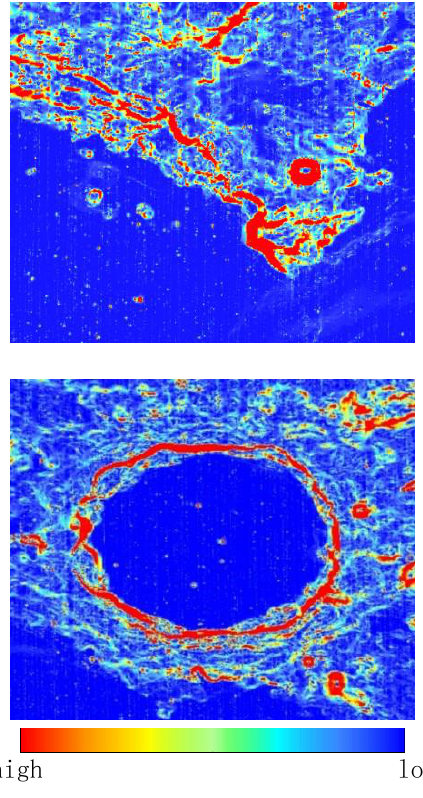
Figure 3. RMSH results images of the tail of Montes Jura southeast (up) and Crater Plato (down)